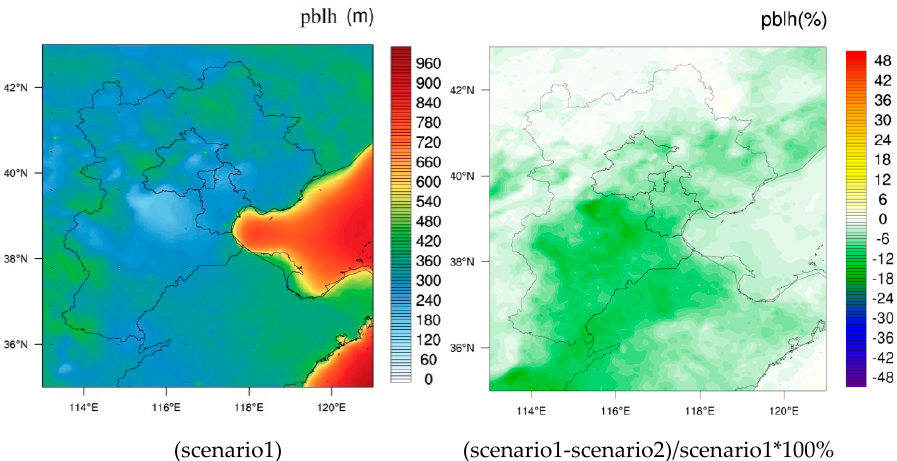
Figure 9. Simulated results of the ARI effects on the planetary boundary layer (PBL).